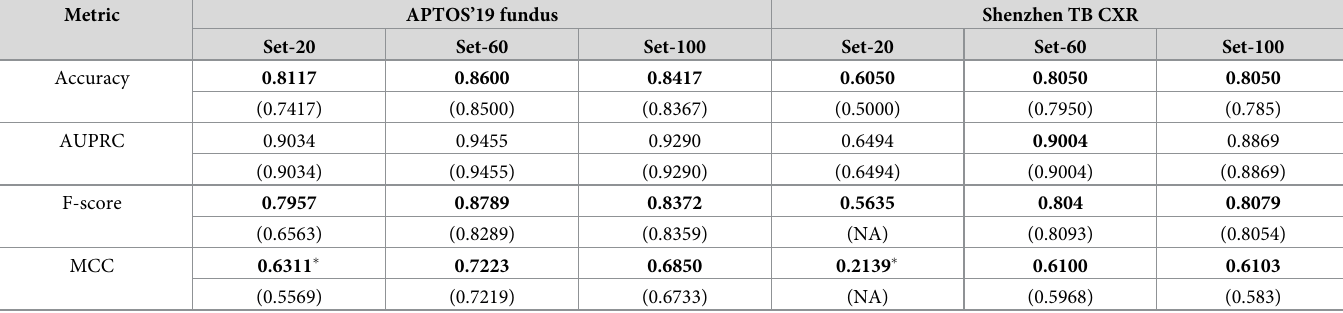
Table 4. Performance metrics achieved at the default operating threshold of 0.5, by the DenseNet-121 and VGG-16 models using calibrated (obtained using the best-performing calibration method from Table 3) and uncalibrated probabilities that are generated for Set-20, Set-60, and Set-100 datasets, constructed from